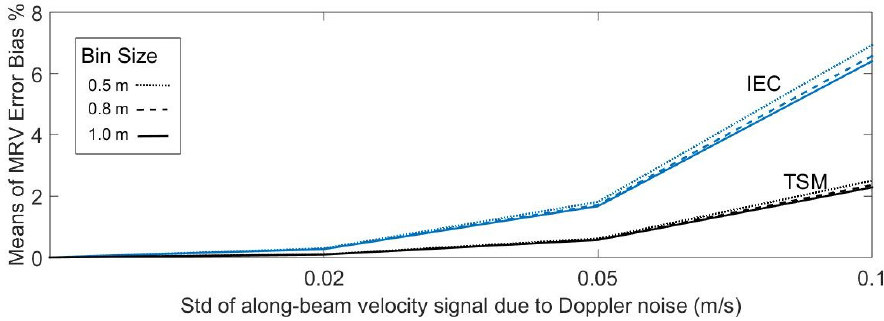
Figure 5. Deviation in means of mean representative current velocity based on different bin